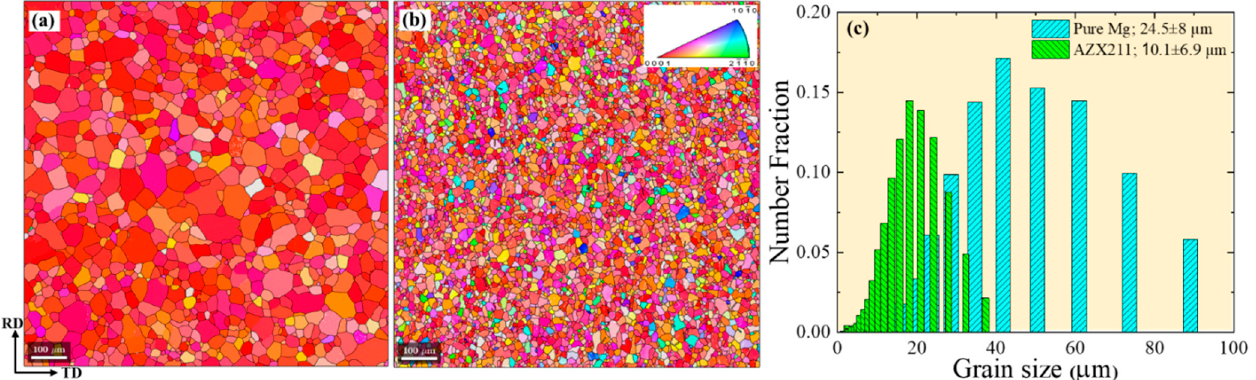
Figure 1. Inverse pole maps (IPF) of ( a ) pure Mg and ( b ) AZX211 and ( c ) grain size distribution of both the samples.